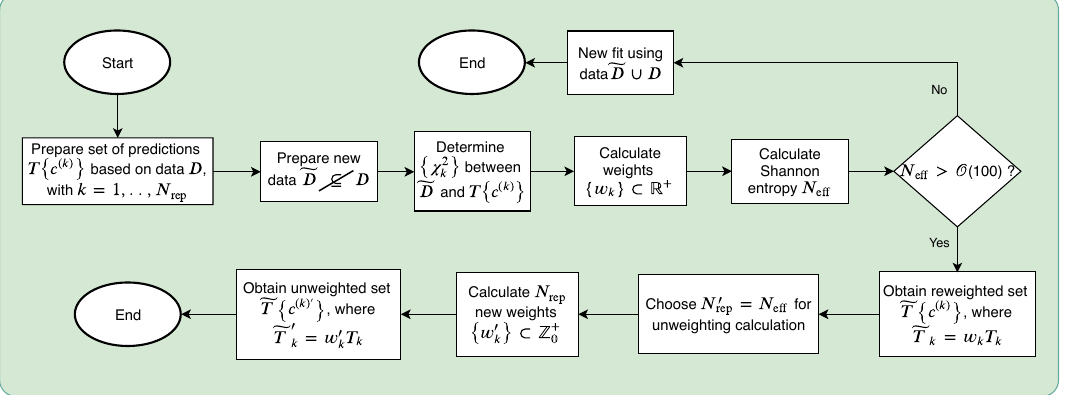
Figure 3.1: Overview of the reweighting / unweighting procedure. The procedure is suc- cessful if the probability distribution associated to the unweighted set coincides with the one from a new